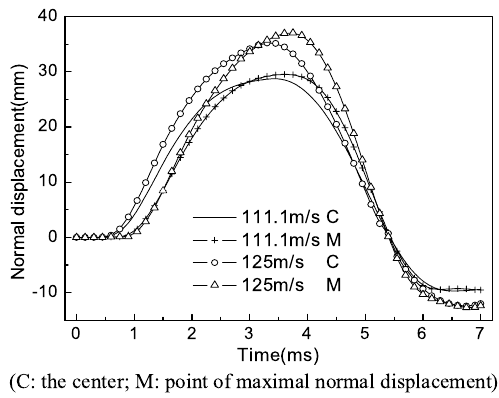
Fig. 9. Time history of normal displacement at the center and point of maximal normal displacement on inner surface. as eight-node solid isoparametric element, nodes-nodes rivet form is applied. All the contact form can be defined